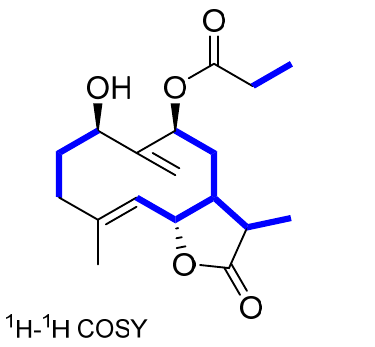
Figure 4. 1 H- 1 H COSY and key HMBC correlations (H → C) of compound 11 .